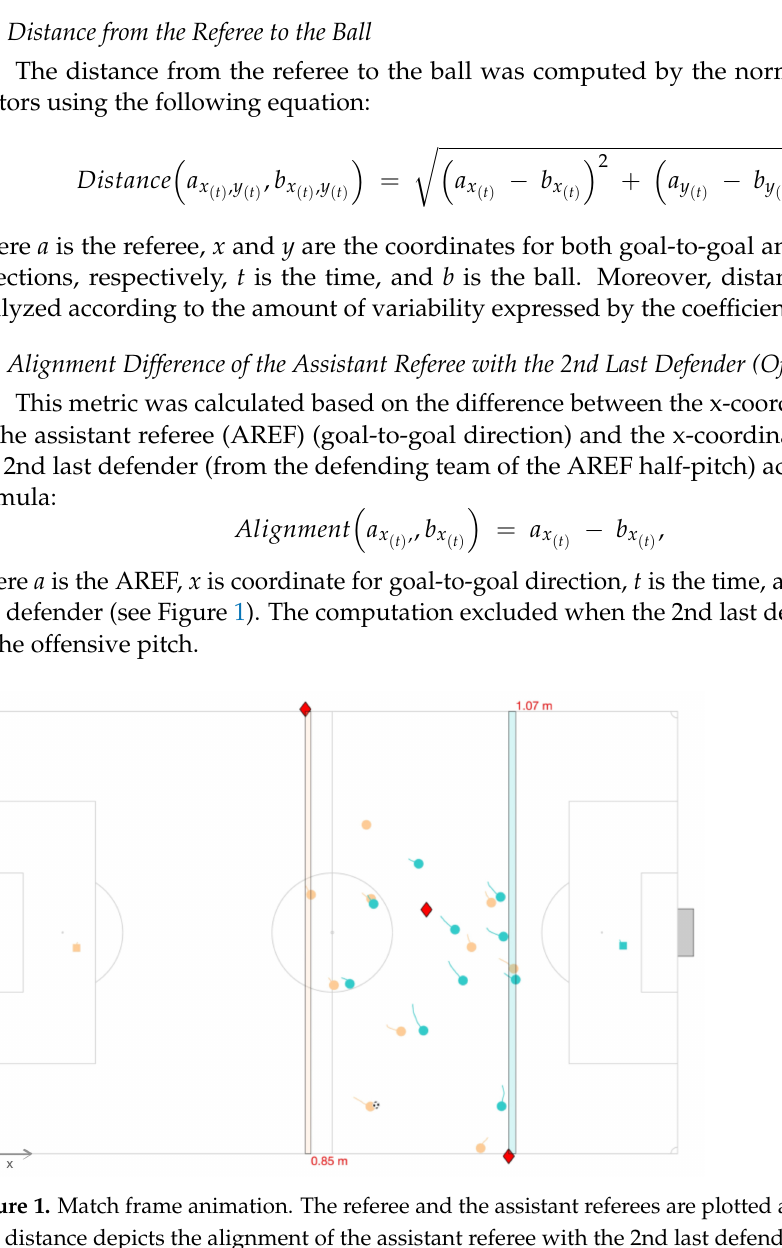
ball was in-play (i.e., all the stoppages were excluded from the analysis). The